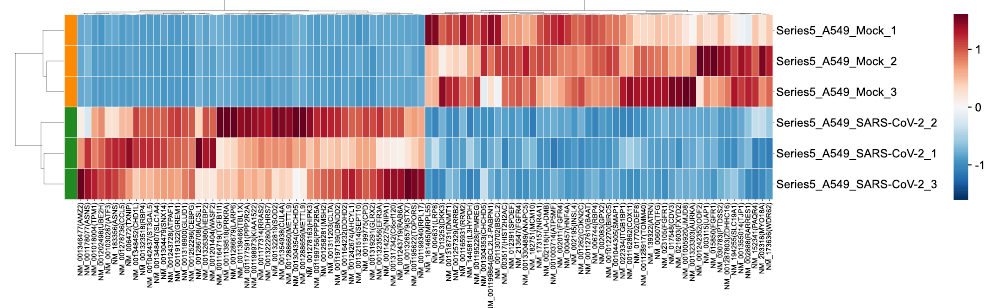
Figure 6. COVID-19 A549 cell lines are clustered by the top 100 transcript markers detected by differential transcript expression